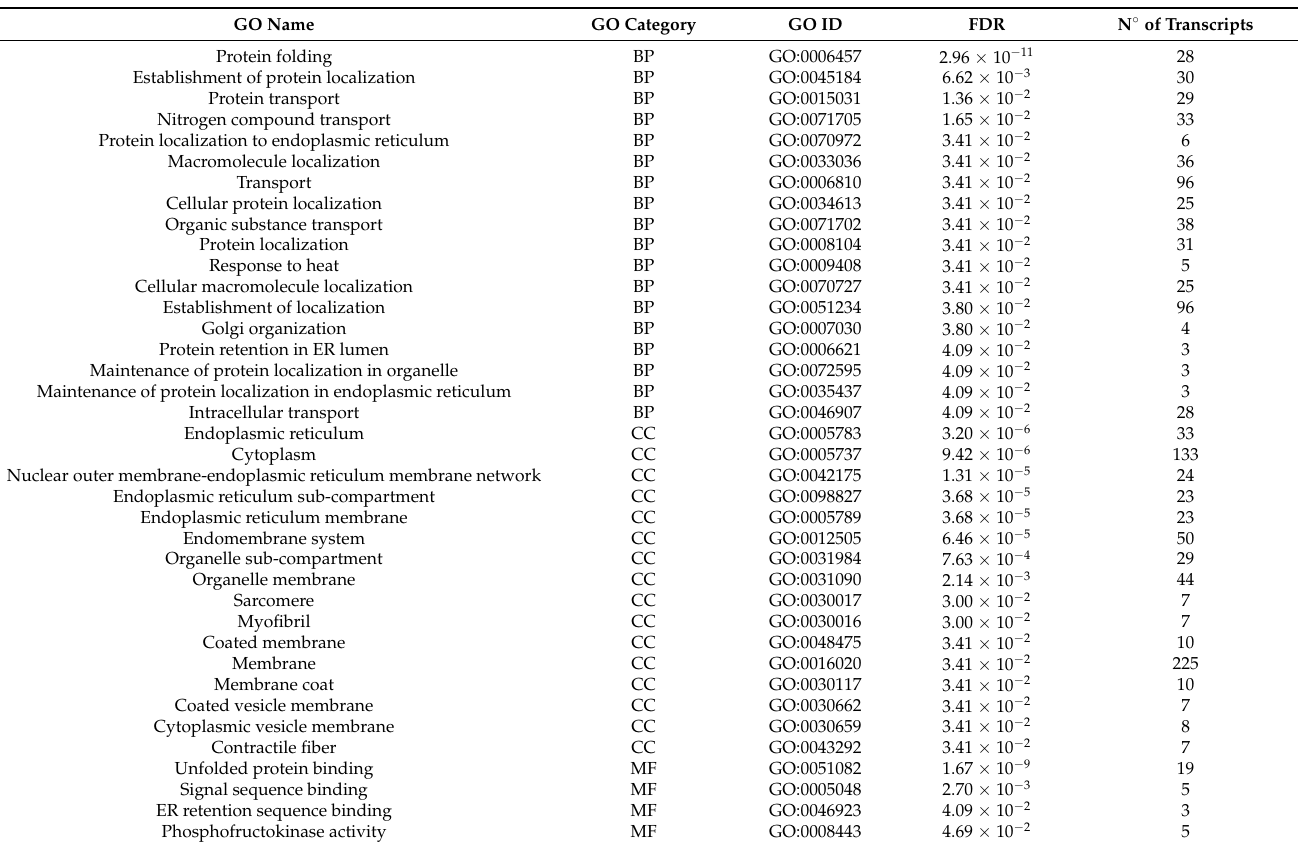
Table 3. Enriched GO terms represented in up-regulated transcripts in response to high-temperature stress in the liver of G. chilensis